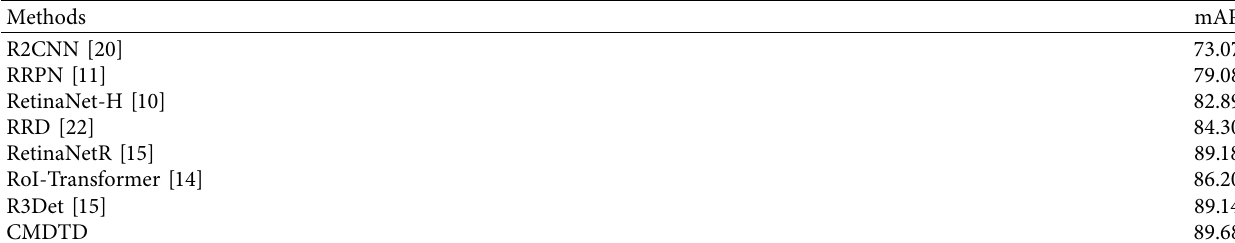
Table 5: ICDAR2015 comparison results